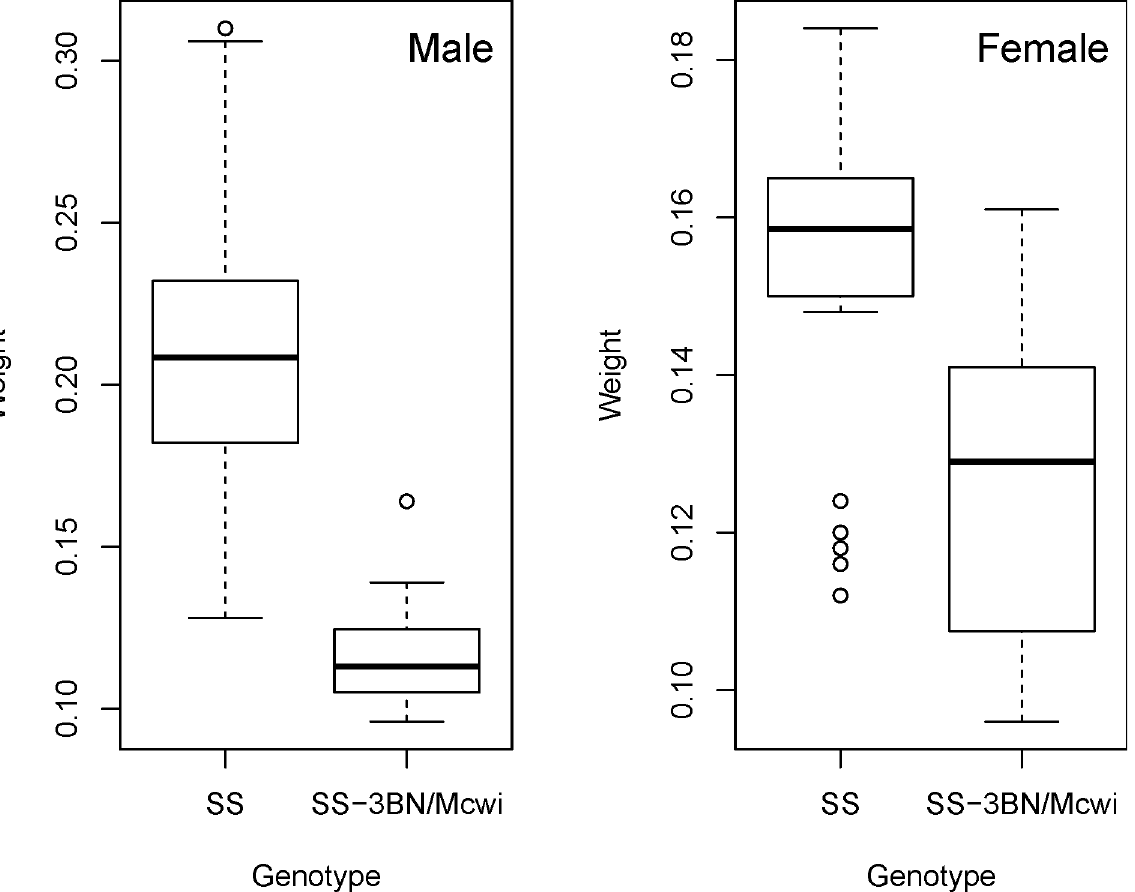
Fig 8. An example body weight phenotype. A graphically visualising of the body weight phenotyping observed in a study of the ischemic peak contracture pressure on rats comparing SS strain to SS-3BN/Mcwi